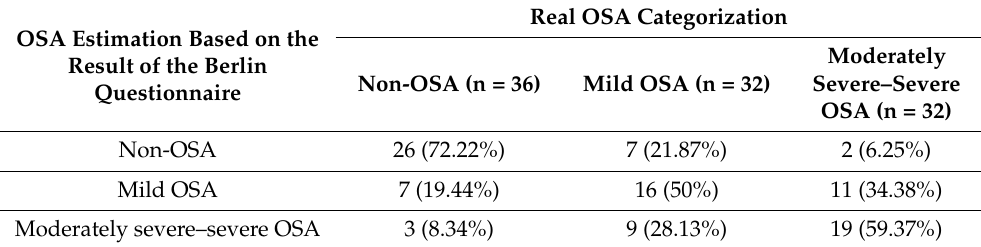
Table 7. OSA category prediction based on the result of the Berlin questionnaire (the table shows the number of cases per 100 patients and the percentage distribution of scores within OSA categories). OSA: obstructive sleep apnoea.